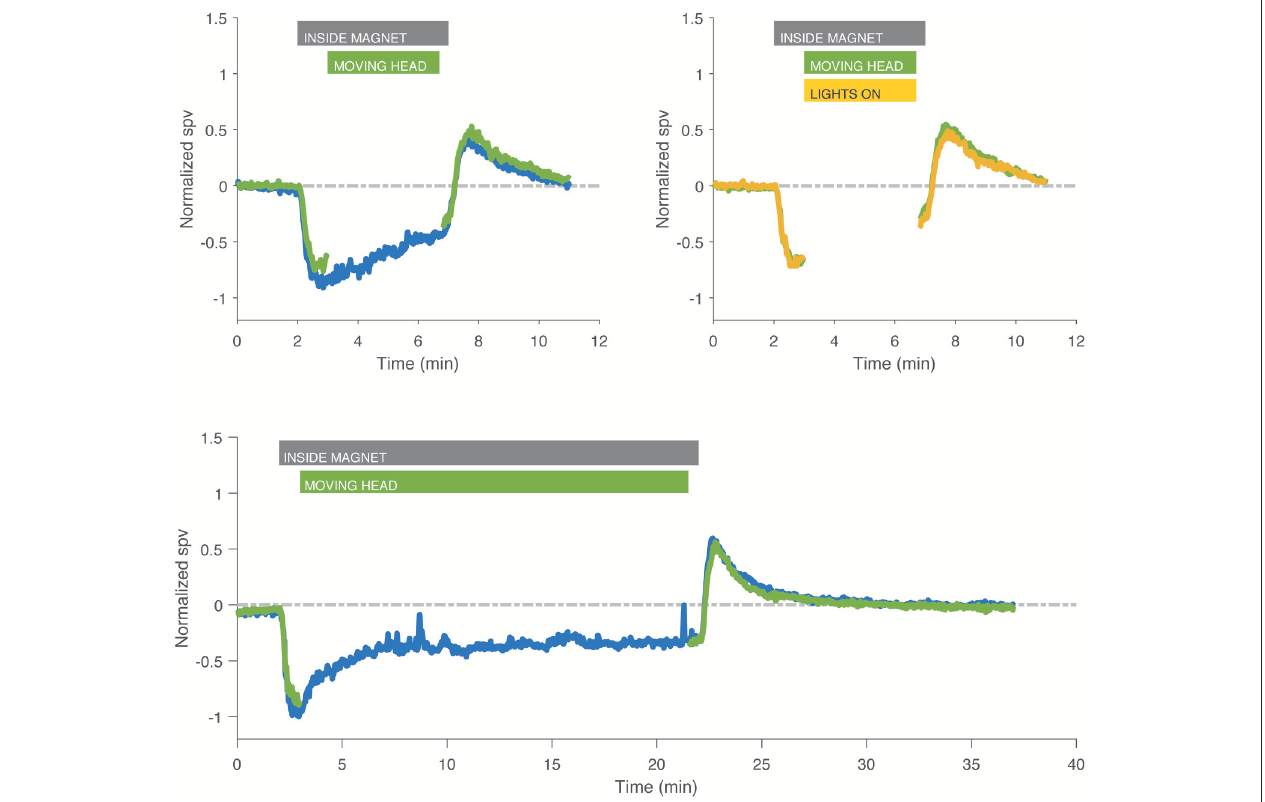
FIGURE 4 | Recordings with head rotations at ∼ 2Hz in the MRI while in darkness (green) or with fixation (yellow) compared to control experiment in darkness without head movement (blue) in two different subjects. Eye movements during the head shaking have been removed for clarity. Head rotations, either in darkness or with fixation, had no effect on the after effect compared to lying still in darkness, nor was there any effect that might have been superposed from a head-shaking induced nystagmus. Gray bar indicates the time the subject was inside the magnet for both trials in darkness and with visual fixation, green bar indicates the time the subject was moving the head, and yellow bar indicates duration of exposure to visual fixation in the light for trials with fixation